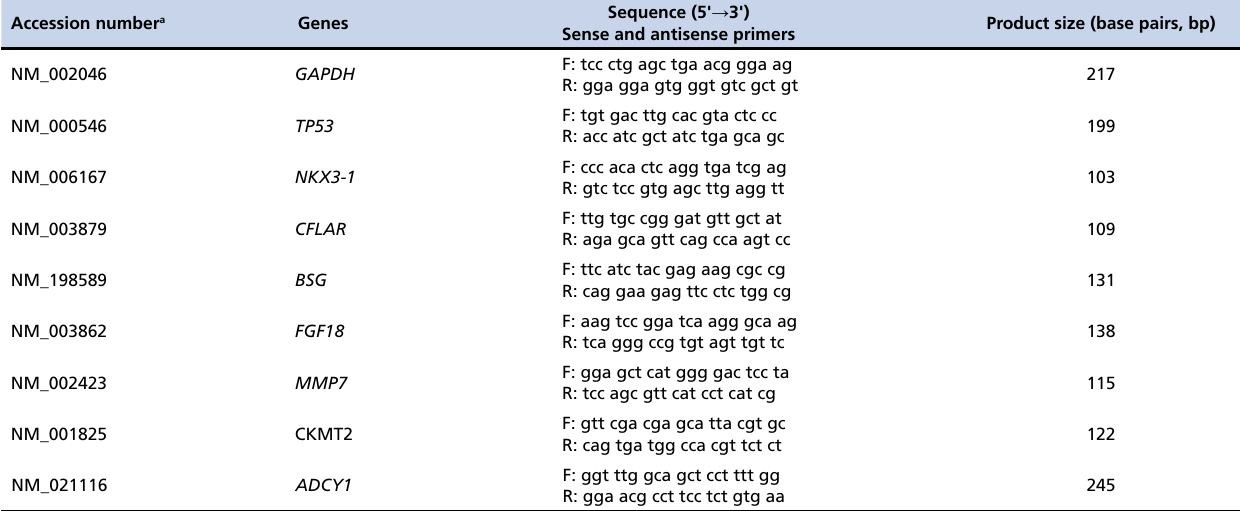
Table 1 - Primer sequences for real-time quantitative RT-PCR.